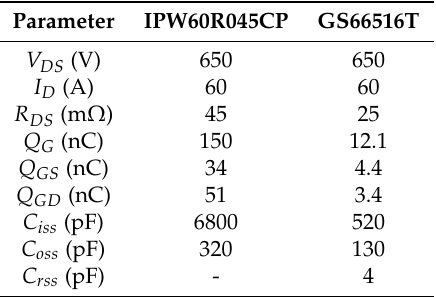
Table 5. Switching devices parameters.